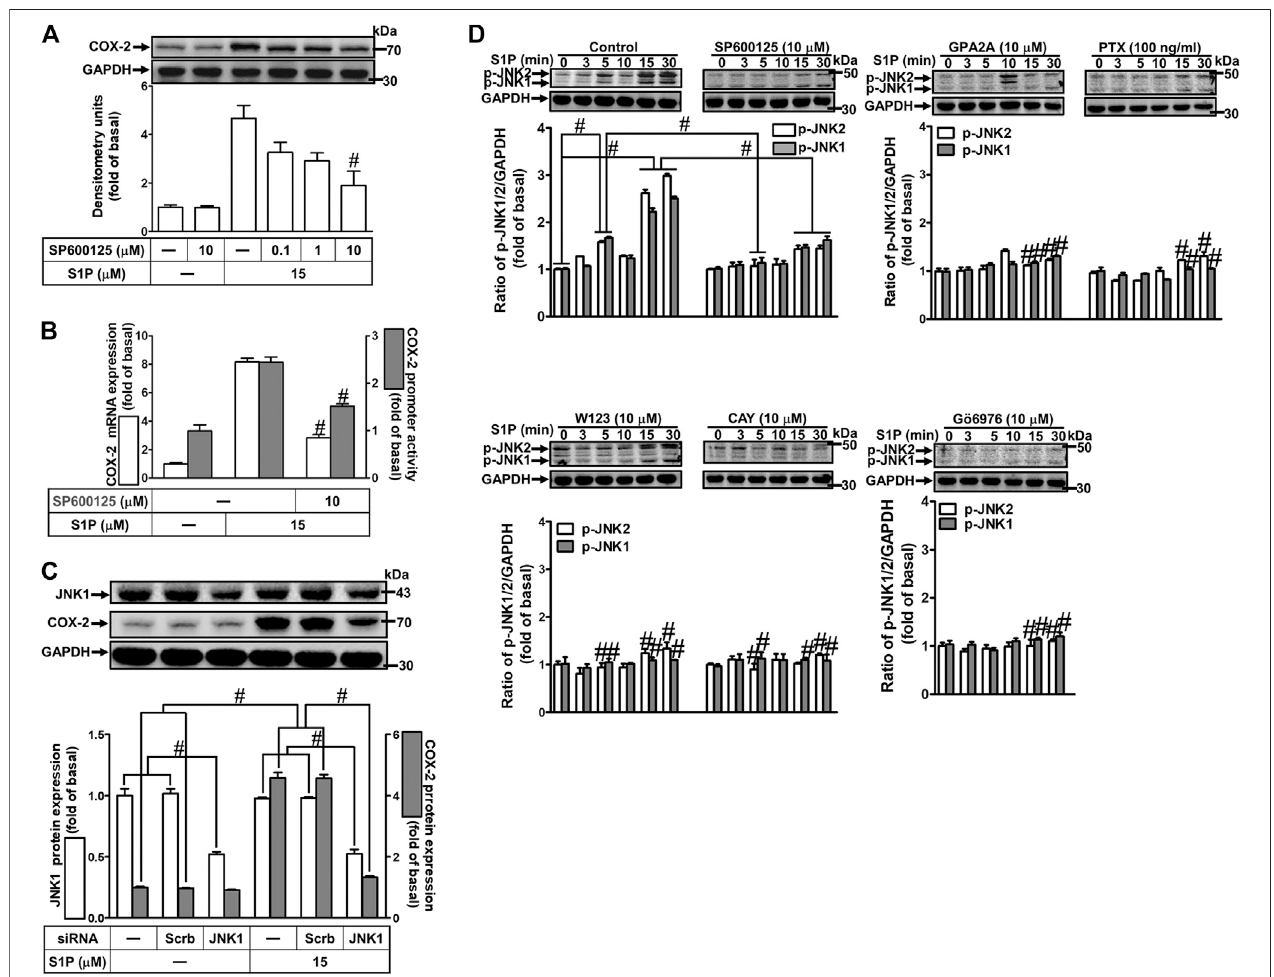
FIGURE 7 | JNK1/2 phosphorylation is involved in S1P-induced COX-2 expression. (A) After pretreatment with SP600125 for 1 h, cells were challenged with 15 μ M S1P for 8 h. (B) Cells were transfected without or with COX-2 promoter-luciferase reporter gene, pretreated without or with SP600125 (10 μ M) for 1 h, and then incubatedwith15 μ MS1Pfor4 h(mRNA)or1 h(promoter).ThelevelsofCOX-2protein,mRNAexpression,andpromoteractivityweredeterminedbyWesternblot,real time-PCR, and promoter assay, respectively. (C) Cells were transfected with siRNA of JNK1 and then exposed to S1P for 8 h. (D) Cells were incubated with S1P (15 μ M) for the indicated time intervals in the absence or presence of SP600125 (10 μ M), W123 (10 μ M), CAY (10 μ M), GPA2A (10 μ M), PTX (100 ng/ml), or Gö6976 (10 μ M) for 1 h. The cell lysates were collected and analyzed by Western blot. The fold of basal was de fi ned as normalization of the data to the respective “ 0, ” and then compared the data of corresponding time points of control vs inhibitor with a statistic method, as described in the section of Methods . Data are expressed as mean ± SEM of three individual experiments (n (cid:2) 3). # p < 0.05, as compared with the cells treated with S1P alone.